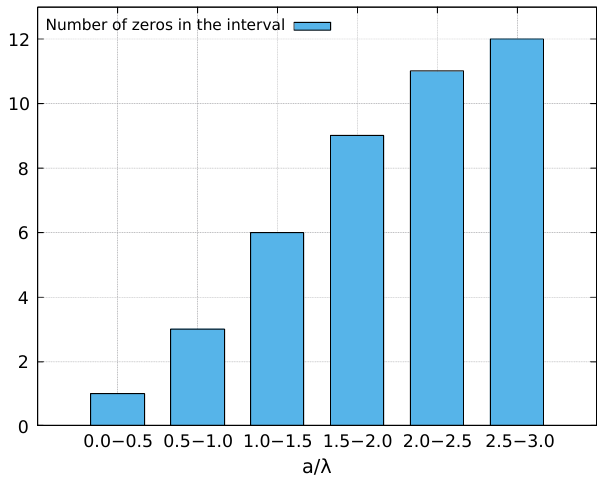
Figure 3. Number of resonances for an enclosure as the radius ranges from 0 to 3 λ